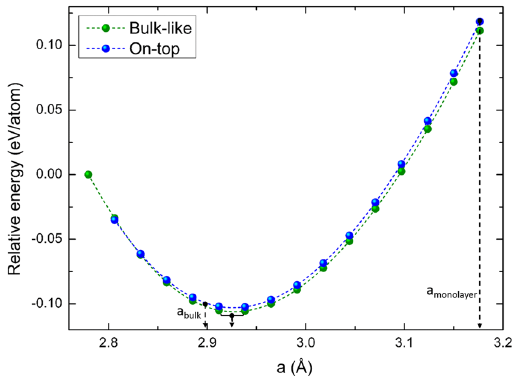
Figure 4. Total energy as function of lattice parameter for both bilayers.